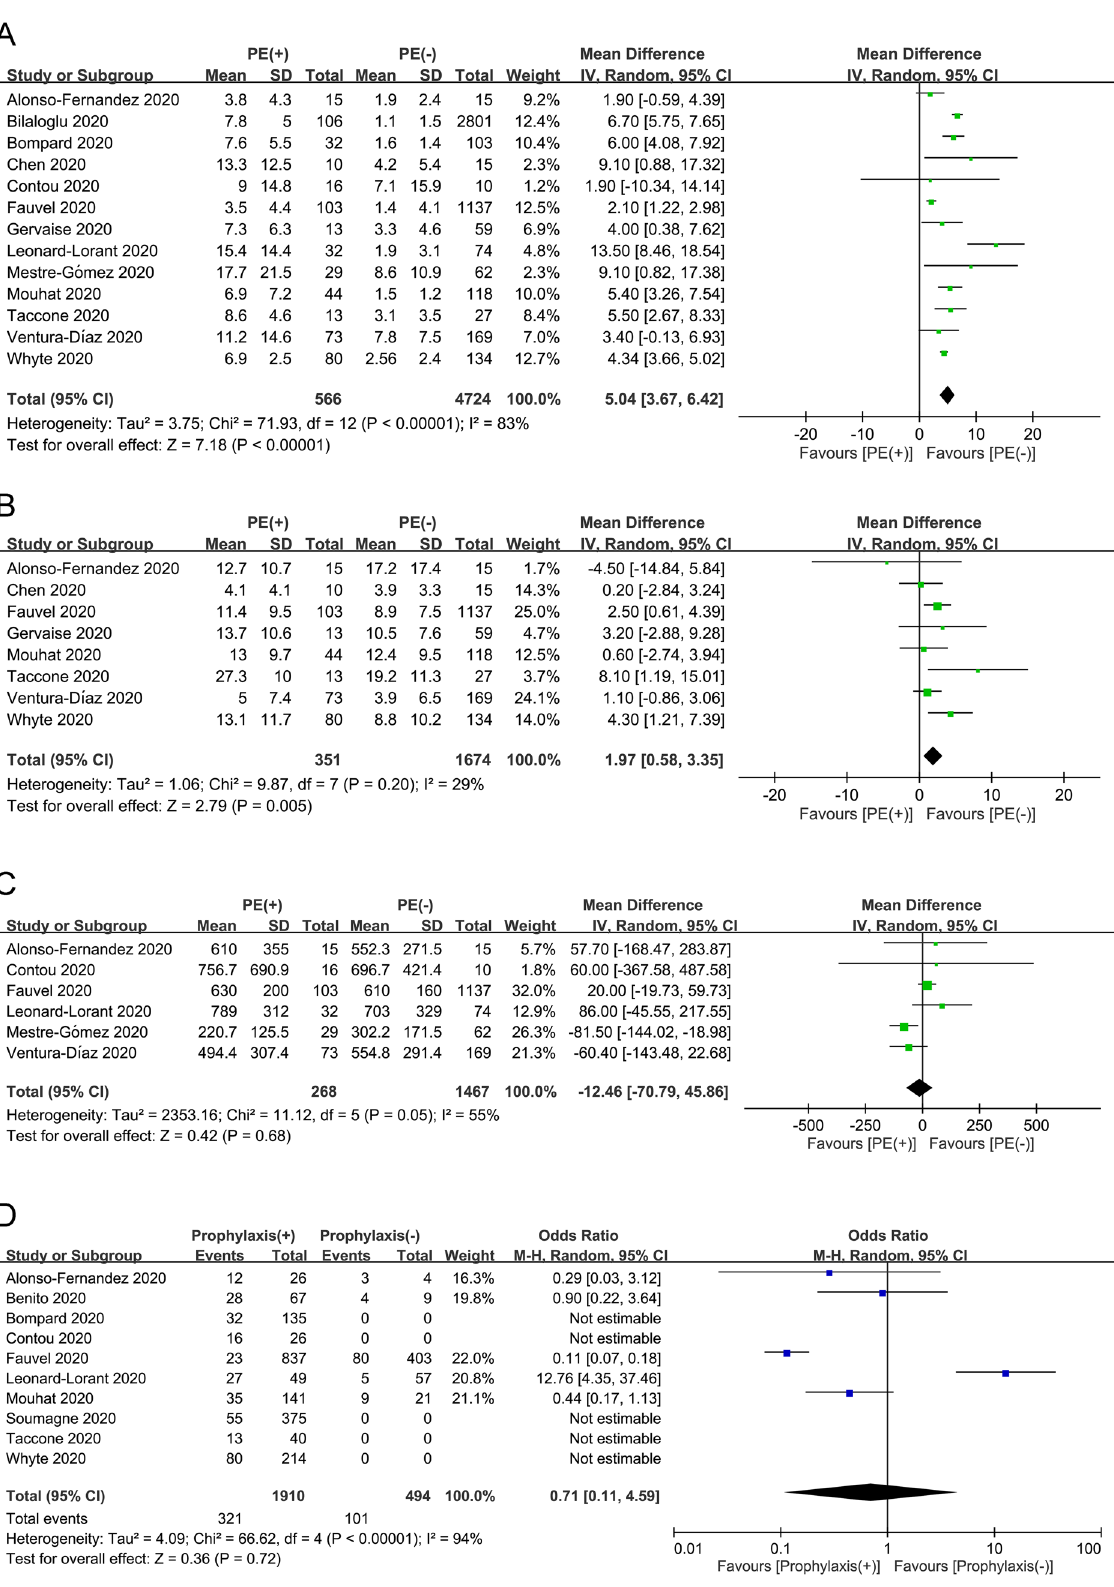
Figure 6. Forest plots for the difference in circulating concentrations of ( A ) D-dimer; ( B ) C-reactive protein; and ( C ) Fibrinogen between pulmonary embolism (PE) and non-PE groups; ( D ) Forest plot for comparing the risk of pulmonary embolism between patients with anticoagulant prophylaxis and those without. CI = confidence interval, IV = inverse variance, M–H =